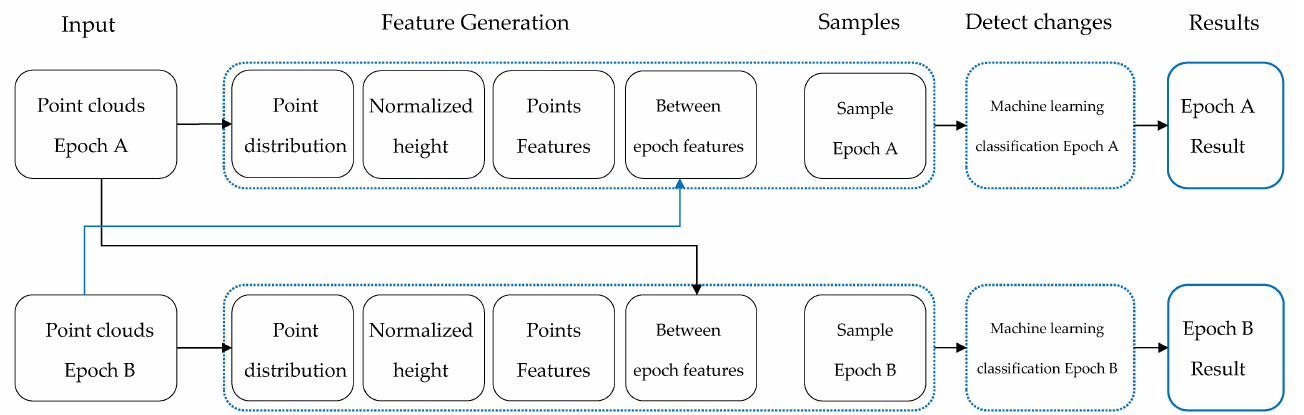
Figure 8. Integrated CD and classification of point clouds using handcrafted feature as in